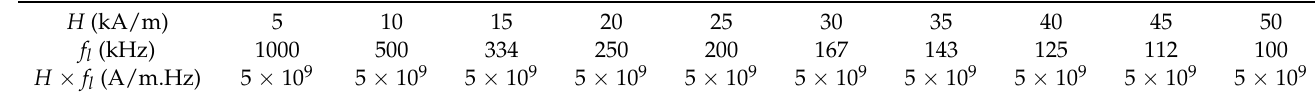
Table 2. Magnetic field and AMF frequency values for the biologically permissible